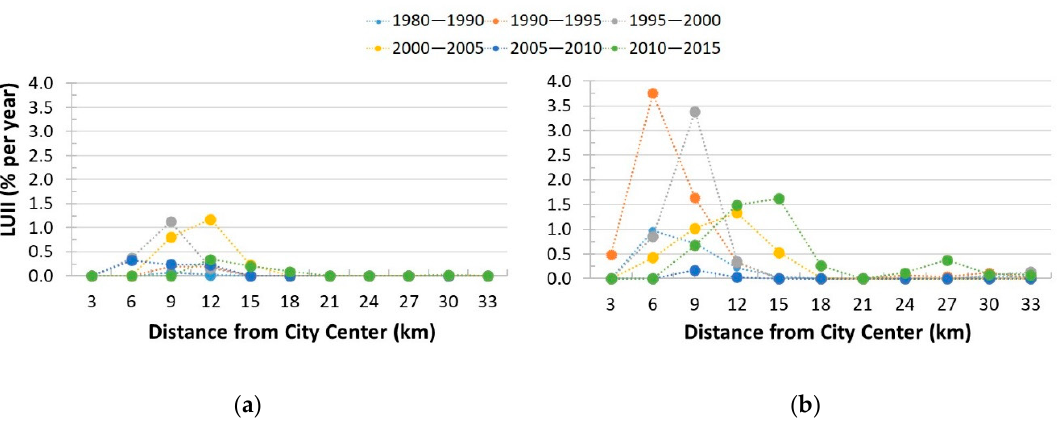
Figure 6. Evolution of the land use intensity index (LUII) over the analyzed period (1980–2015) along the urban–rural gradient for two categories: ( a ) conversion from rural built-up to urban built-up area, and ( b ) conversion from farmland to urban built-up